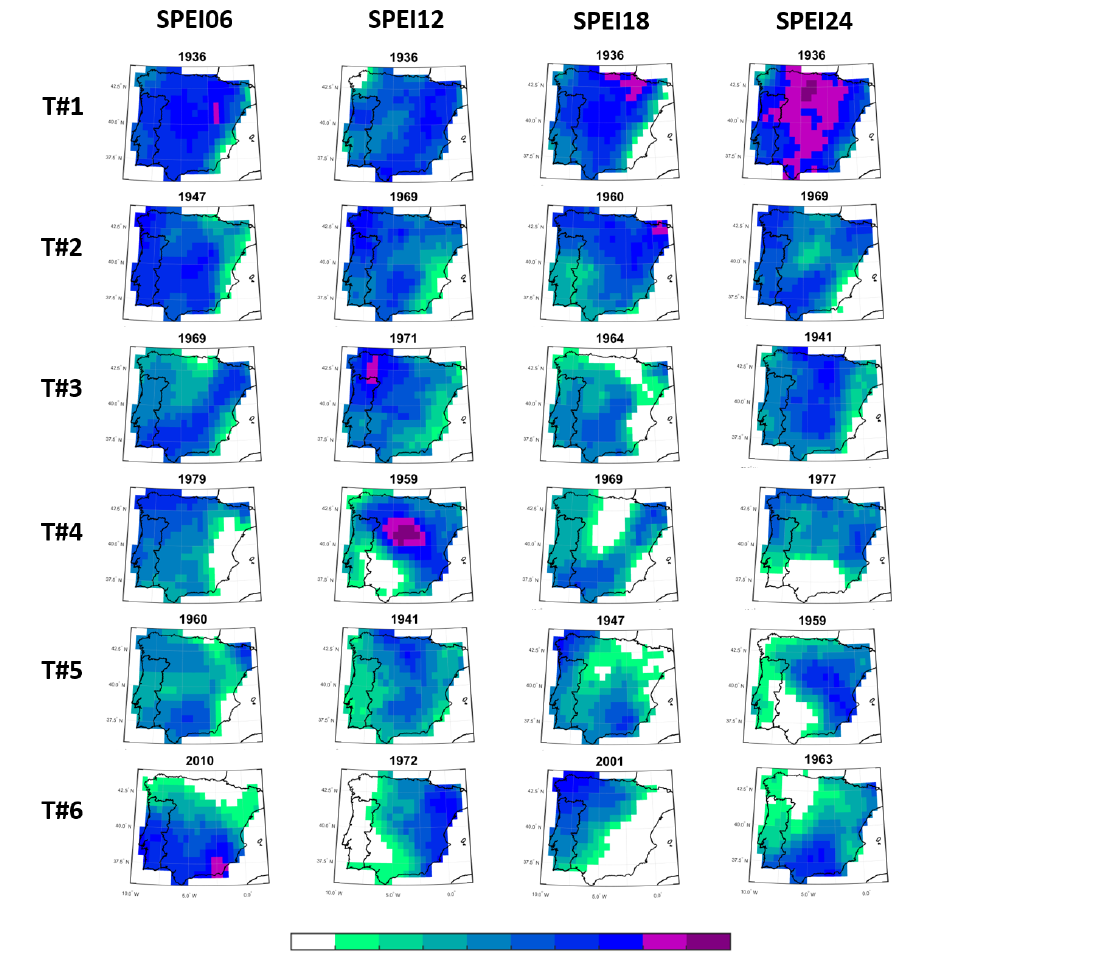
Figure 5. The top 6 wet events in the Iberian Peninsula domain for the 6-month timescale SPEI for March (first column), the 12-month timescale SPEI for September (second column), the 18-month timescale SPEI for March (third column), and the 24-month timescale SPEI for September (fourth